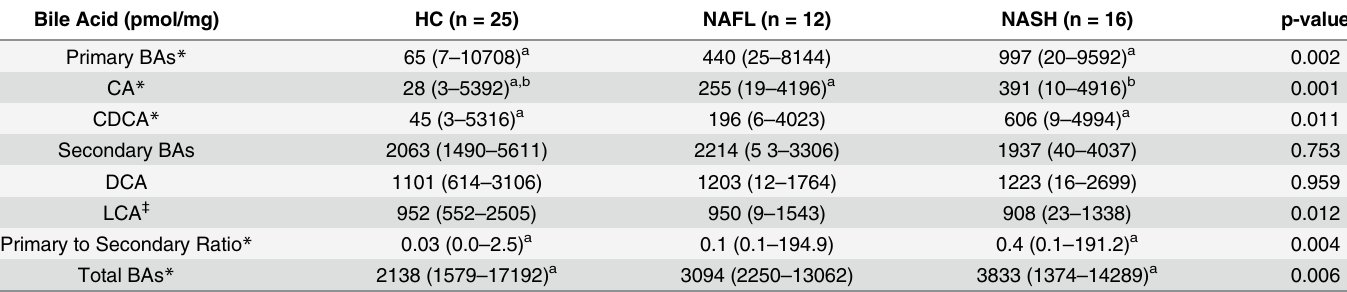
Table 2. Unconjugated fecal bile acid composition and comparisons between the groups (n =